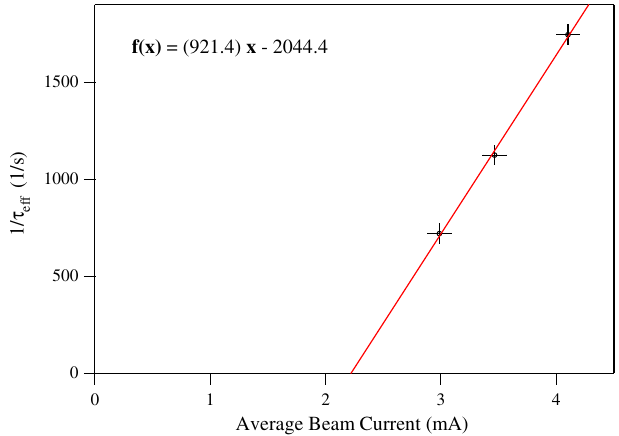
FIG. 9. (Color) A plot of the three values of 1 =(cid:2) ing to each macropulse current from Fig. 8 versus the macro- pulse current. The threshold current is 2.2 mA and is extracted in the same manner as the BTF